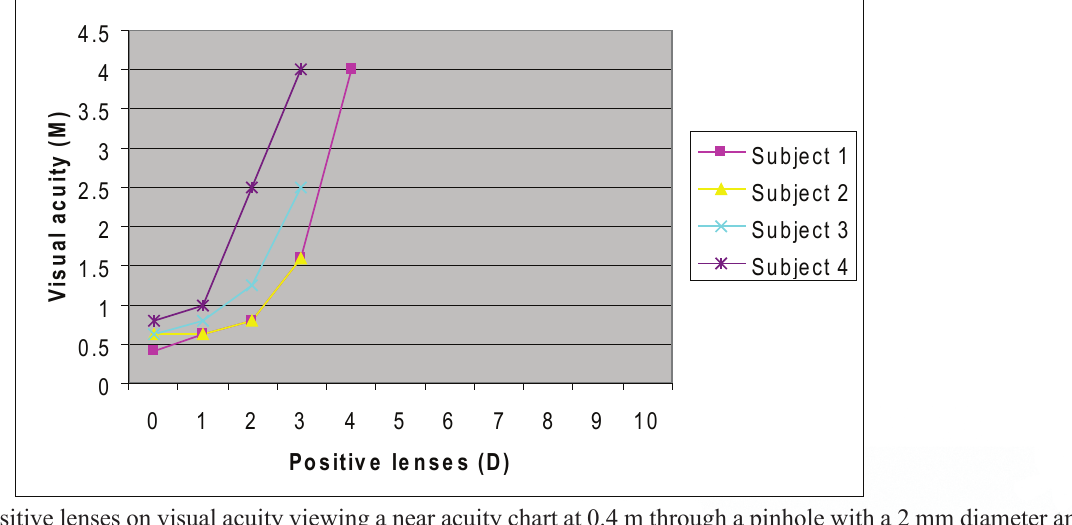
Figure 6. Effect of positive lenses on visual acuity viewing a near acuity chart at 0.4 m through a pinhole with a 2 mm diameter and illumination of 1